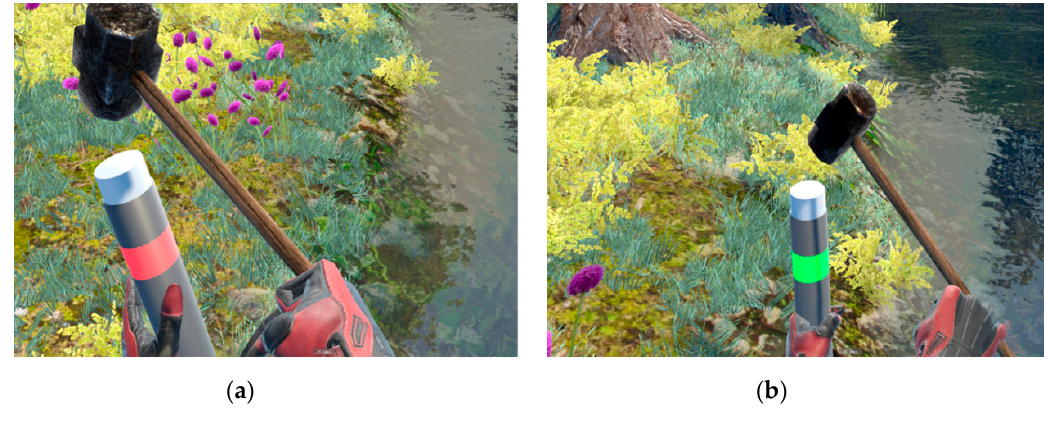
Figure 6. ( a ) Misplaced post and ( b ) correctly placed post.